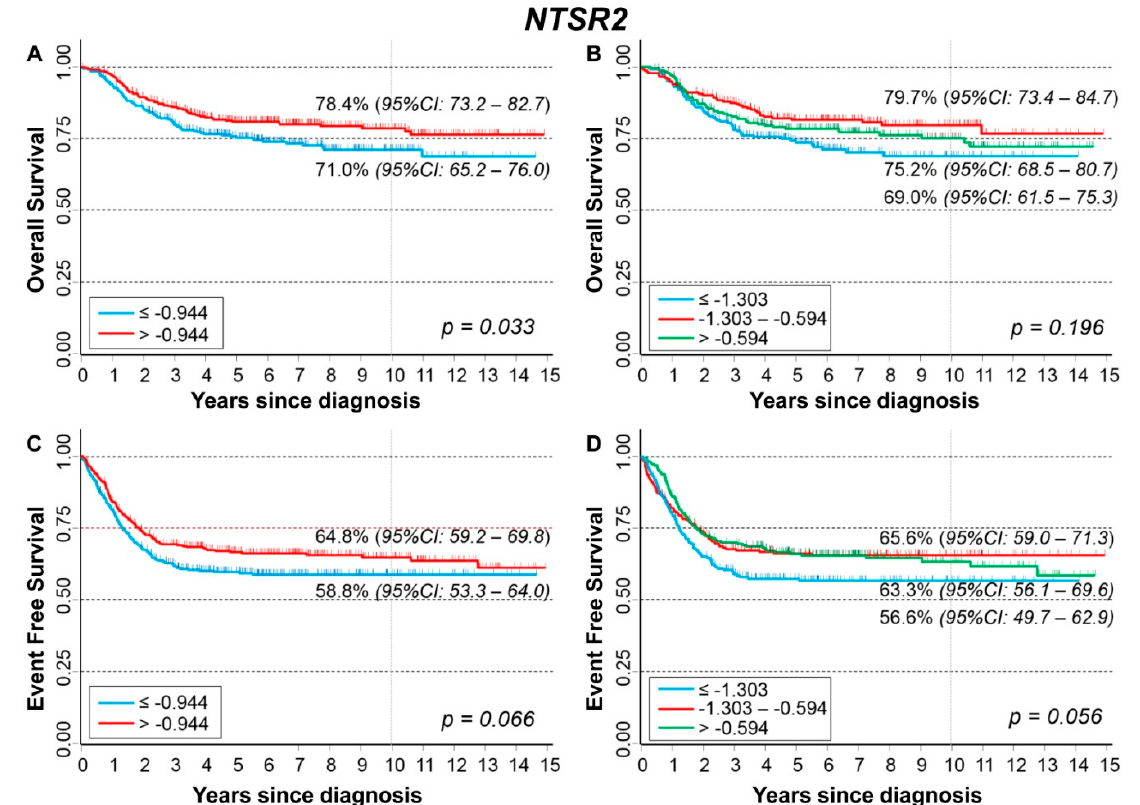
Table 19. Overall Survival of 709 NB patients in relation to NTSR2 expression levels evaluated by the Cox regression model.